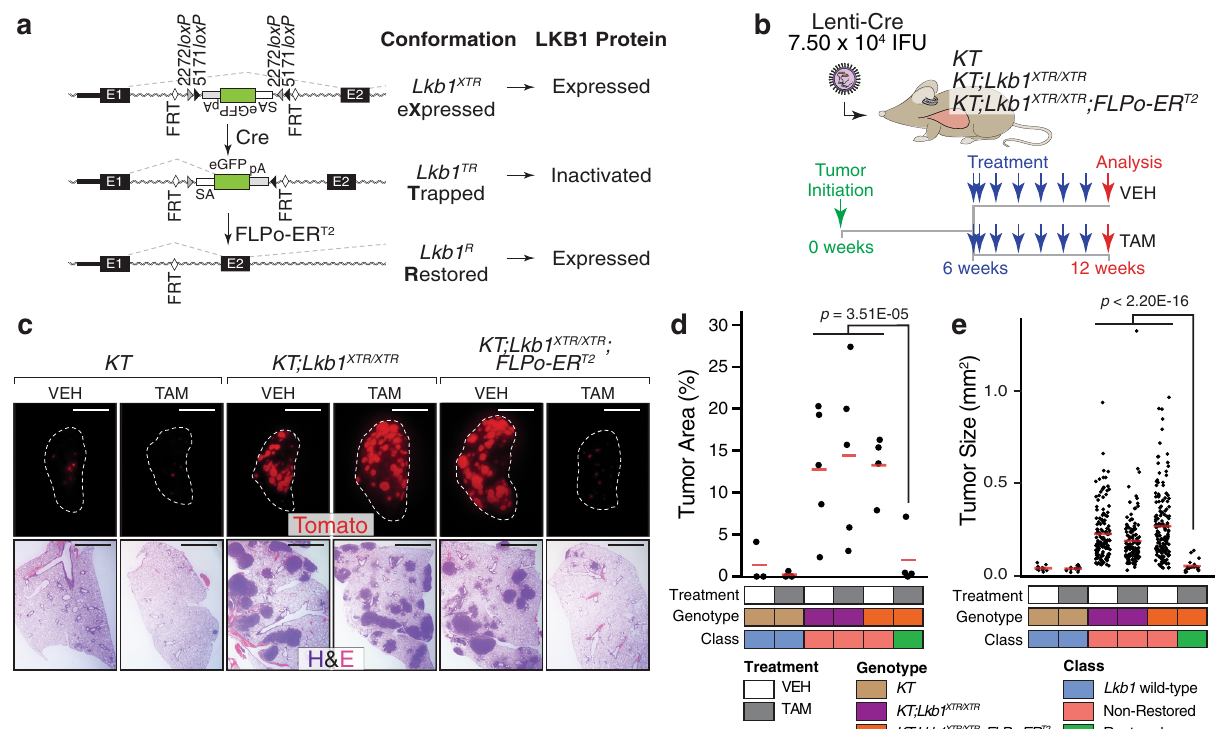
Fig. 1 Lkb1 restoration in established lung tumors dramatically decreases lung tumor burden. a Schematic of the XTR cassette inserted within the fi rst intron of Lkb1 in the eXpressed, Trapped, and Restored conformations. The XTR cassette is composed of an inverted gene trap consisting of an Ad40 splice acceptor upstream of eGFP. The gene trap is fl anked by heterotypic loxP sites to allow for stable Cre-mediated inversion, which results in the truncation of wild-type Lkb1 transcripts. The gene trap is nested between two FRT sites to enable FLPo-ER T2 -mediated deletion in the presence of tamoxifen, which results in the restoration of wild-type Lkb1 transcripts and LKB1 protein. b Assessment of the impact of Lkb1 restoration on tumor burden. Lung tumors were initiated in KT , KT;Lkb1 XTR/XTR , and KT;Lkb1 XTR/XTR ;FLPo-ER T2 mice. At 6 weeks post-initiation, tumor-bearing mice were treated for 6 weeks with corn oil vehicle or tamoxifen prior to analysis. IFU infectious units, VEH vehicle, TAM tamoxifen. c Representative fl uorescence (top) and hematoxylin – eosin (H&E) staining (bottom) images of tumor-bearing lungs from KT , KT;Lkb1 XTR/XTR , and KT;Lkb1 XTR/XTR ;FLPo-ER T2 mice treated with vehicle or tamoxifen. Lung lobes within fl uorescent images are outlined in white. Top scale bars = 5 mm. Bottom scale bars = 2 mm. d , e Tumor area ( d ) and tumor size ( e ) as assessed by histology for tumor-bearing KT , KT;Lkb1 XTR/XTR , and KT;Lkb1 XTR/XTR ;FLPo-ER T2 mice at 12 weeks after tumor initiation, following 6 weeks of treatment with vehicle